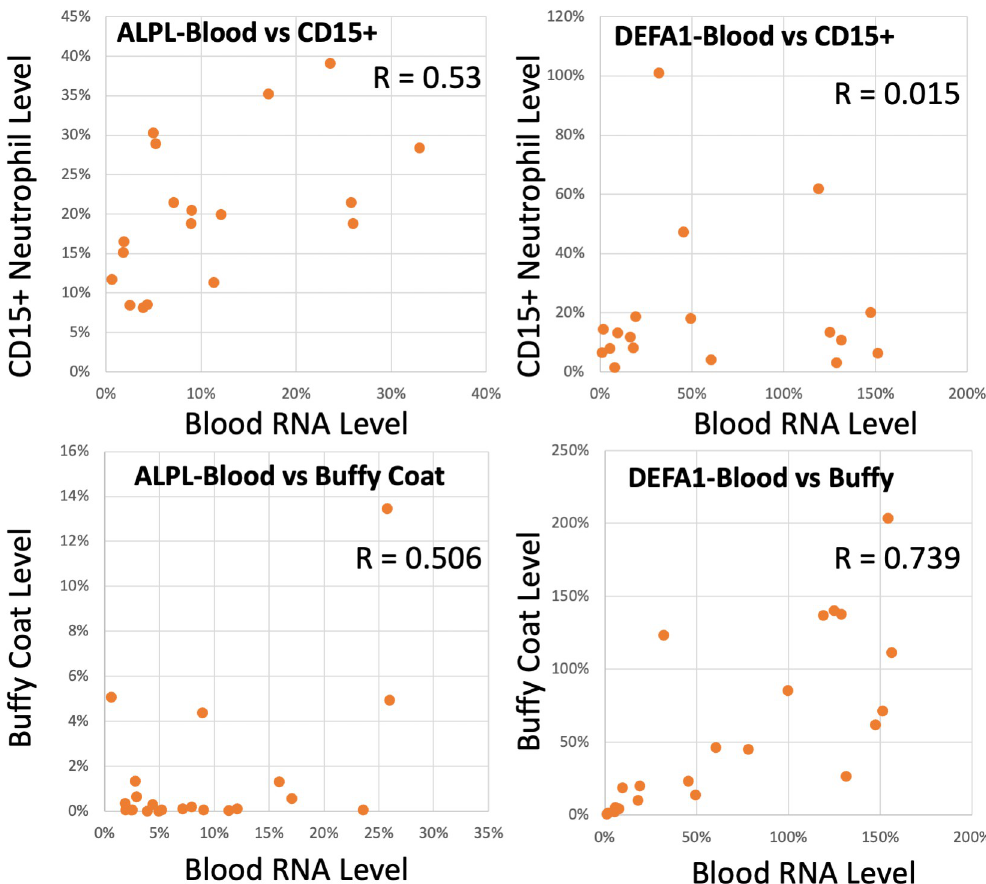
Fig 5. Whole blood RNA levels vs purified CD15+ neutrophil or buffy coat levels of immune activation markers. In a subset of COVID-19 patients, whole blood RNA was compared to RNA from purified CD15+ neutrophils (n = 16) or buffy coat (n = 22) from the same patients for 6 mRNA biomarkers using ddPCR quantitation. Each point represents a single patient quantified for ALPL (left panels) or DEFA1 (right panels) RNA in whole blood RNA vs purified CD15+ neutrophils (upper panels) or buffy coat RNA (lower panels). All RNA levels are expressed as % of ACTB in the same ddPCR